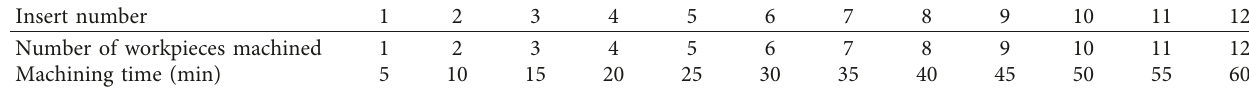
Table 2: Machining time of all carbide